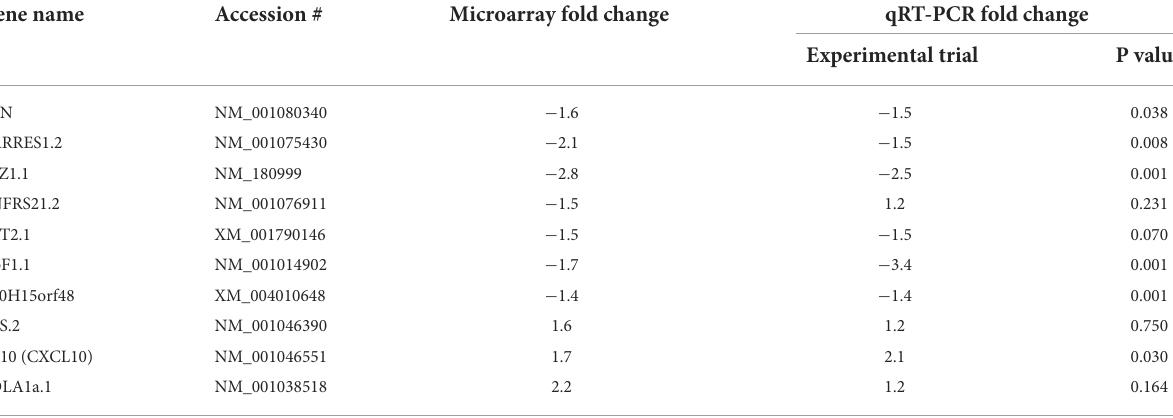
TABLE 5 Fold change comparison of the observed array gene expression and the qPCR validation of expression in experimentally exposed sheep.